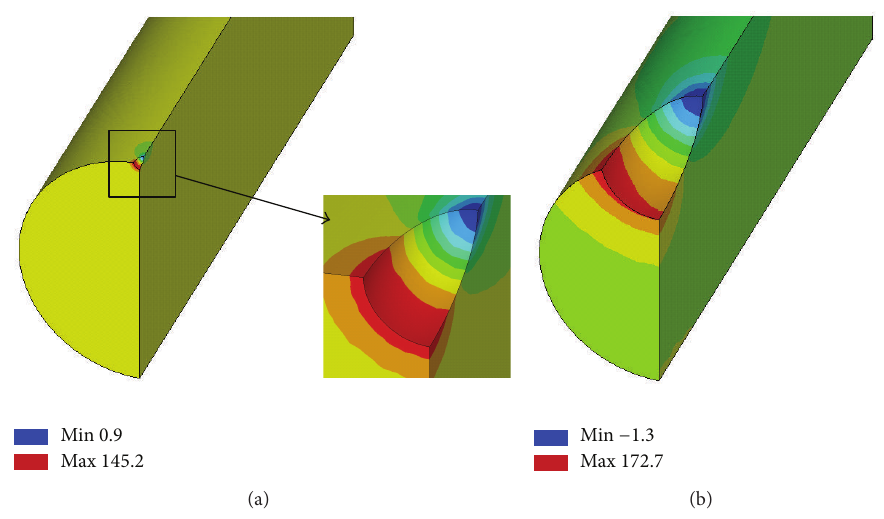
Figure 7: Stress distributions near the pit with various relative depths: (a) 𝑎/𝑅 = 0.05 , (b) 𝑎/𝑅 = 0.5 .